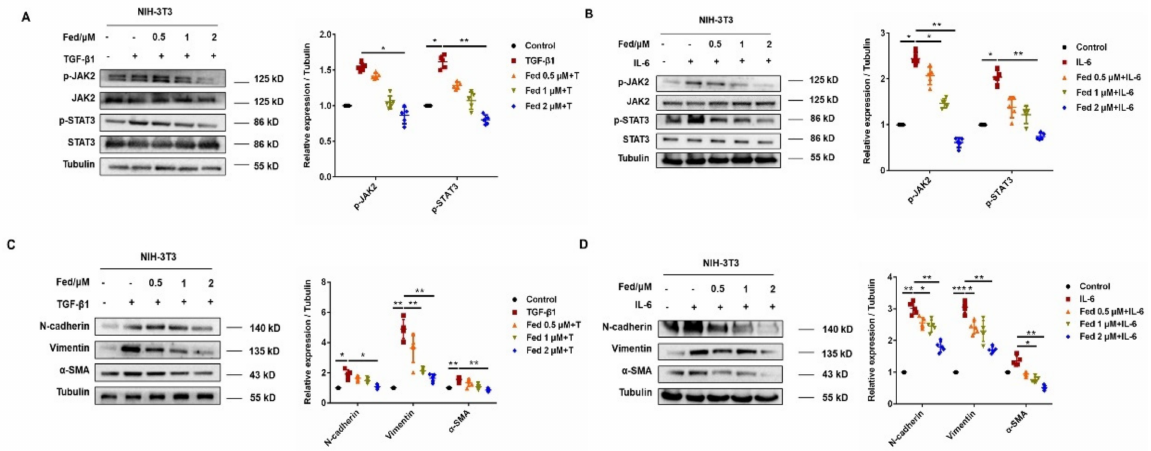
Figure 2. Fedratinib inhibits fibroblast-to-myofibroblast transitions by inhibiting the JAK2 and STAT3 signaling pathways. ( A , B ) JAK2/p-JAK2 and STAT3/p-STAT3 protein expression in NIH-3T3 cells. ( C , D ) NIH-3T3 cells were treated with TGF- β 1 or IL-6 and Fed (0.5, 1 and 2 µ M) for 24 h. Protein expression levels of E-cadherin, vimentin and N-cadherin were assessed by Western blot. β -tubulin was used as a loading control in grayscale analysis. Data are presented as the means ± SD ( n = 5). Comparisons between groups were achieved using one-way analysis of variance (ANOVA). * p < 0.05, ** p < 0.01, *** p <